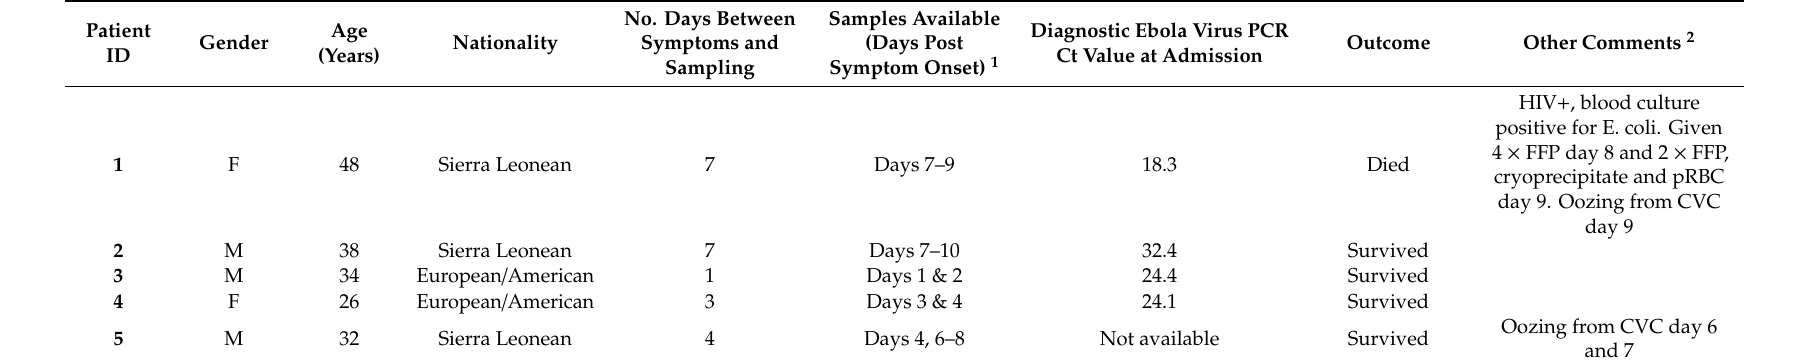
Table 2. Details of Patients and samples available for this